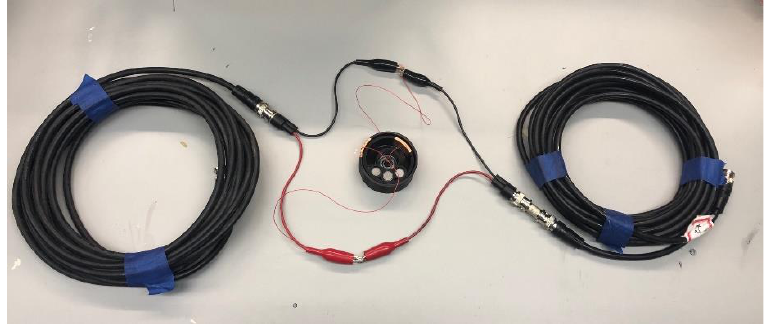
Figure 7. The tilt sensor is connected as part of a transmission line setup using RG-6 coaxial cables.